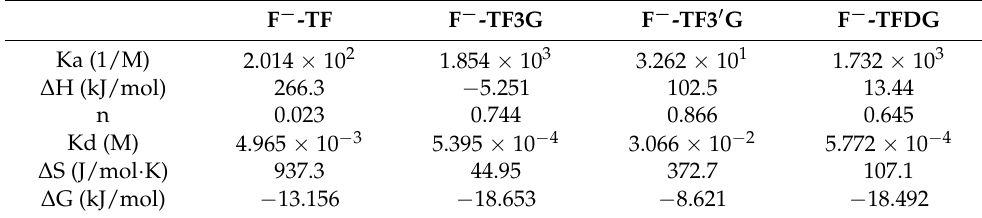
Table 4. Thermodynamic parameters of interaction between F − and